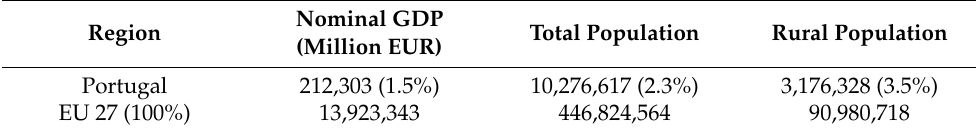
Table 1. Portugal and EU: comparative GDP, population and rural population, in 2019 [7].